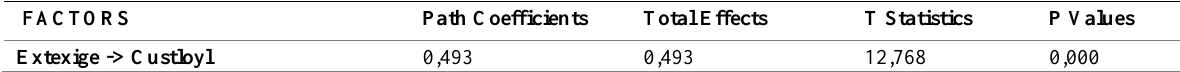
Table 4: Path Coefficients and Total Effects